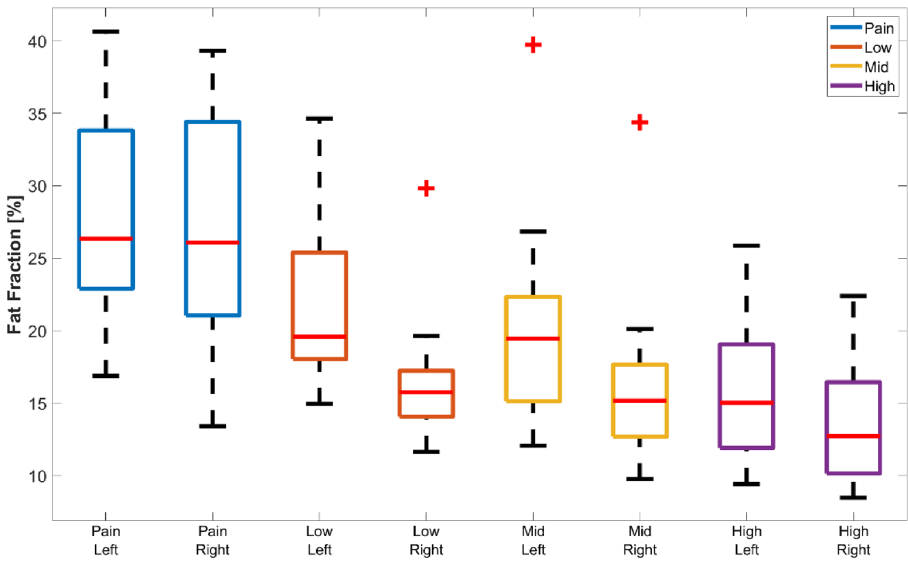
Figure 4. Boxplots of GMAX FF values for left and right side for each group under study. On each box, the central mark is the median, the edges of the box are the 25th and 75th percentiles. The outliers are plotted individually. Left FF was significantly higher than right in the low and mid activity groups ( p < 0.05).